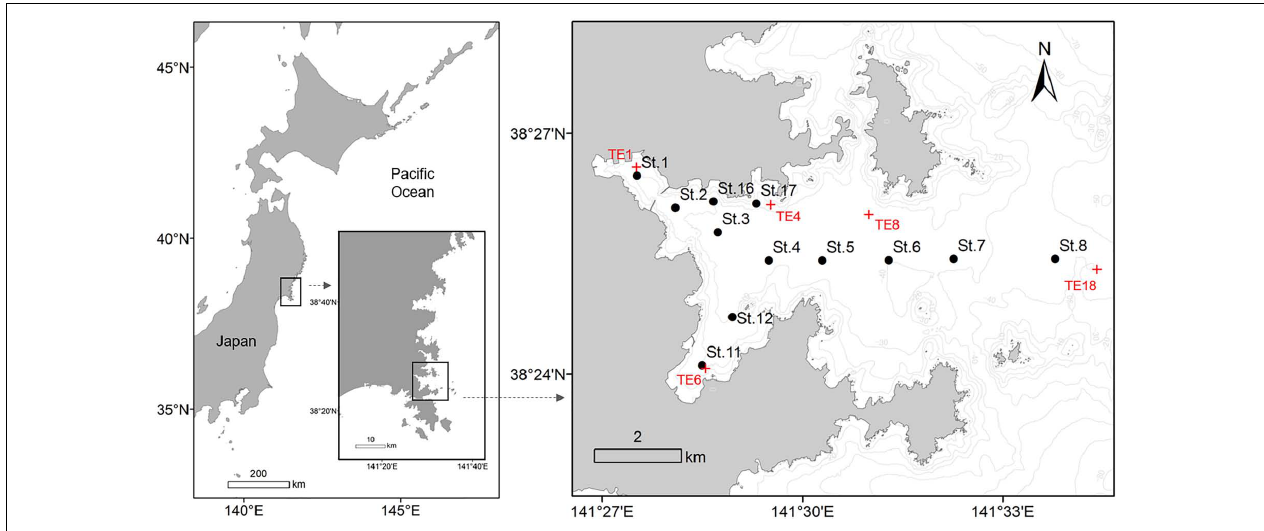
FIGURE 1 | Map of Onagawa Bay, Japan, showing sampling stations for the Onagawa Bay Monthly Survey on board RV Suikoh from March 2012 onward (filled black circles: St.1–8, 11, 12, 16, and 17). Red cross symbols (TE1, 4, 6, 8, and 18) indicate locations of five of the sampling stations for the long-term environmental survey program conducted by Miyagi Prefecture and Tohoku Electric Power Company that provided comparative pre-tsunami data.